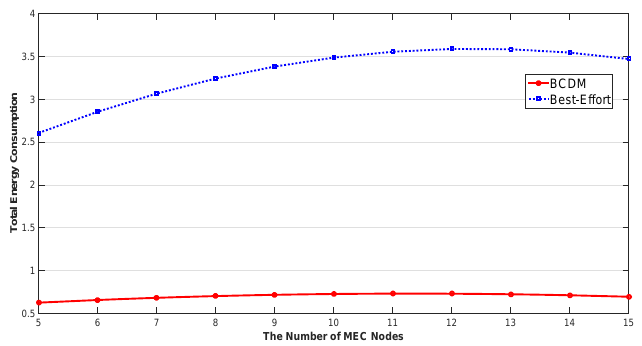
Figure 10. The Impact of the Number of MEC Nodes to Total Energy Consumption.